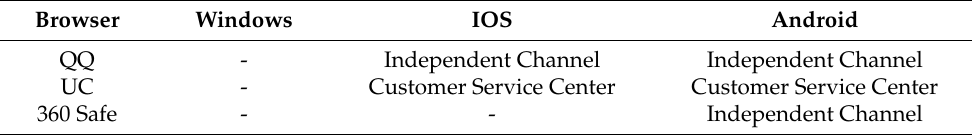
Table 10. Different browsers have different forms of reporting platforms.